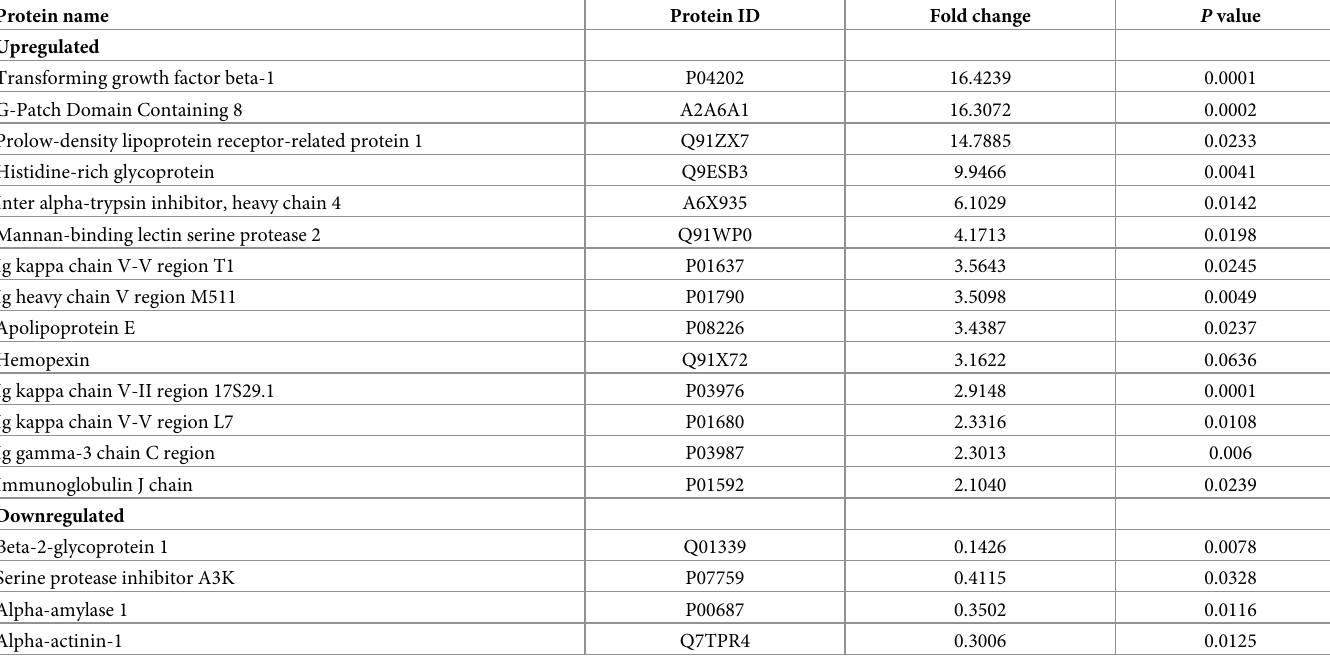
Table 1. Summary of the differentially abundant proteins in serum-derived exosomes from E . multilocularis -infected